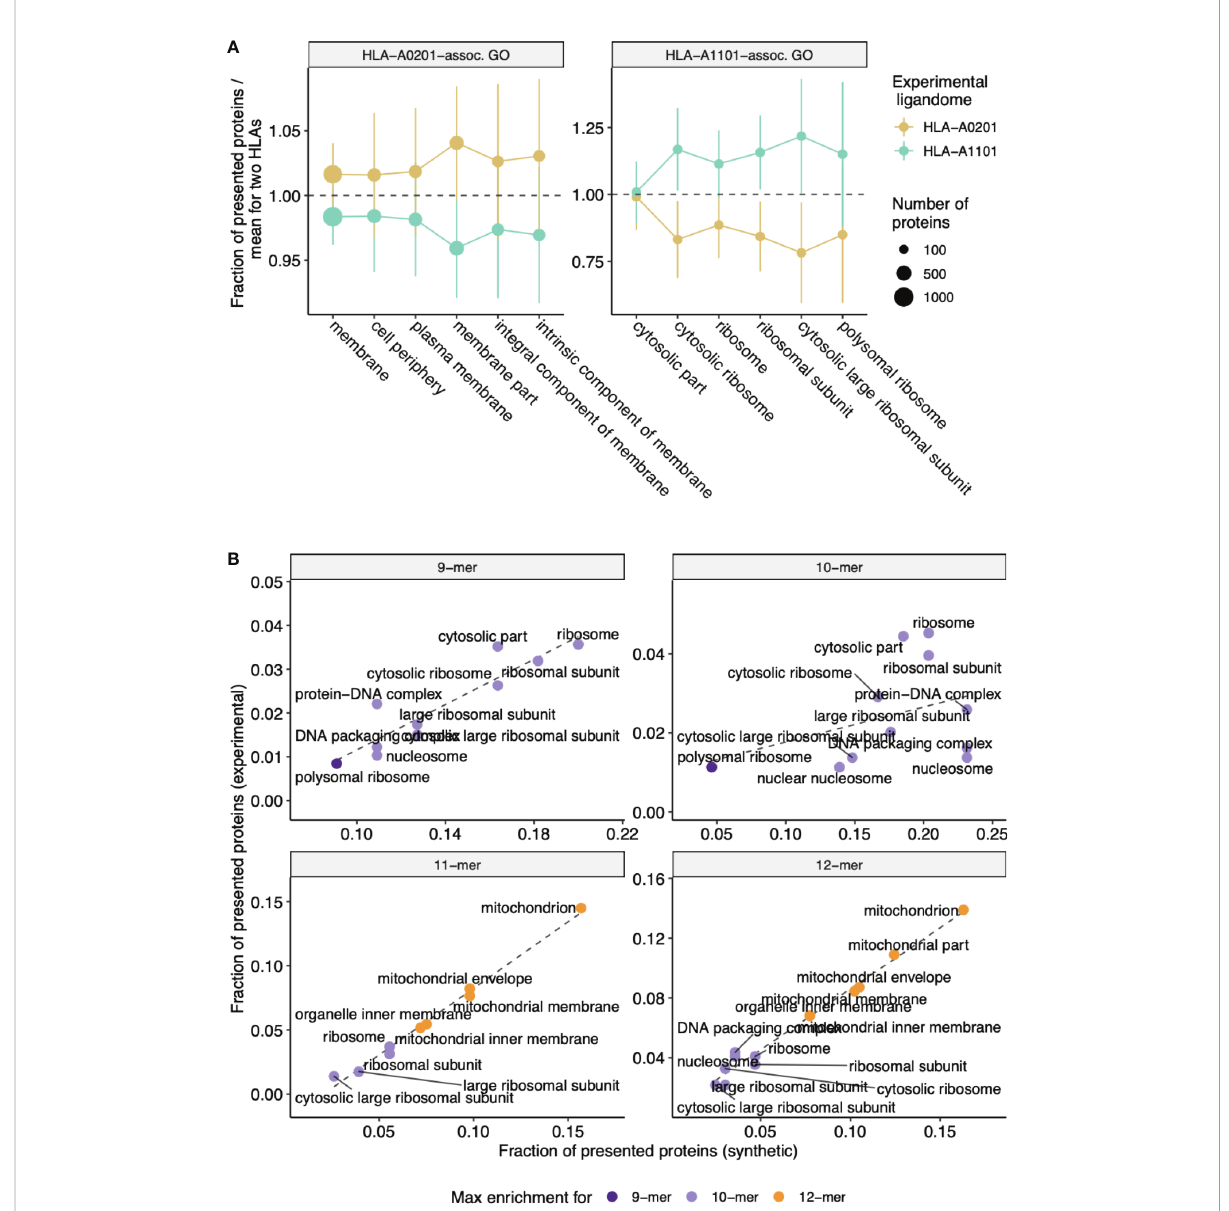
FIGURE 4 Experimental validation of biased selection of self proteins presented by different HLA alleles and different HLA ligand lengths. (A) Fraction of proteins presented by experimentally obtained HLA-A*02:01 and HLA-A*11:01 ligandomes that correspond to a given GO category. The fraction is normalized by mean value for two alleles to highlight differences between proteins related to HLA-A*02:01 and HLA-A*11:01 alleles. Cellular component (CC) GO categories associated with proteins which are frequently presented by either HLA-A*02:01 (left panel) or HLA-A*11:01 (right panel) according to in silico predictions were selected to match those in Figure 2B. Error bars show 1 standard deviation of fractions. (B) Scatterplot compares the fraction of proteins presented by HLA-A*11:01 ligands of various lengths that correspond to a given GO category between in silico predictions and experimental data. CC GO categories associated with 9-12-mer ligands were selected to match those in Supplementary Figure 5. Color shows ligand length at which maximum fold enrichment is reached for a given GO